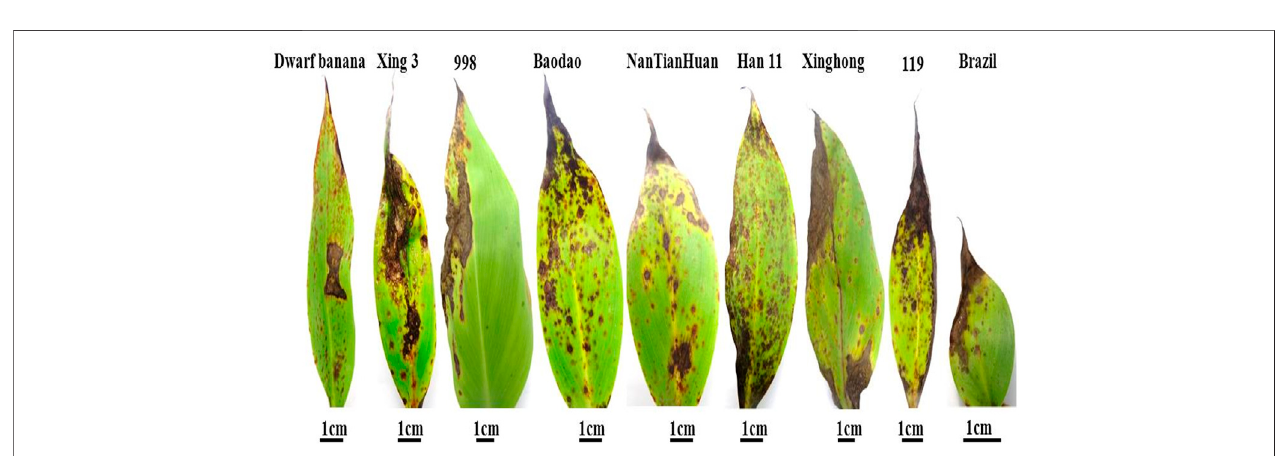
FIGURE 1 | Spore shape of rice blast fungus from a different host. R07, R03, R02, R04, R01, R05, R06, R08 were collected from Banana, Digitaria sanguinalis , Eleusine coracana , Eleusine indica , Oryza sativa , Oryza sativa , Oryza sativa , Oryza sativa , respectively .